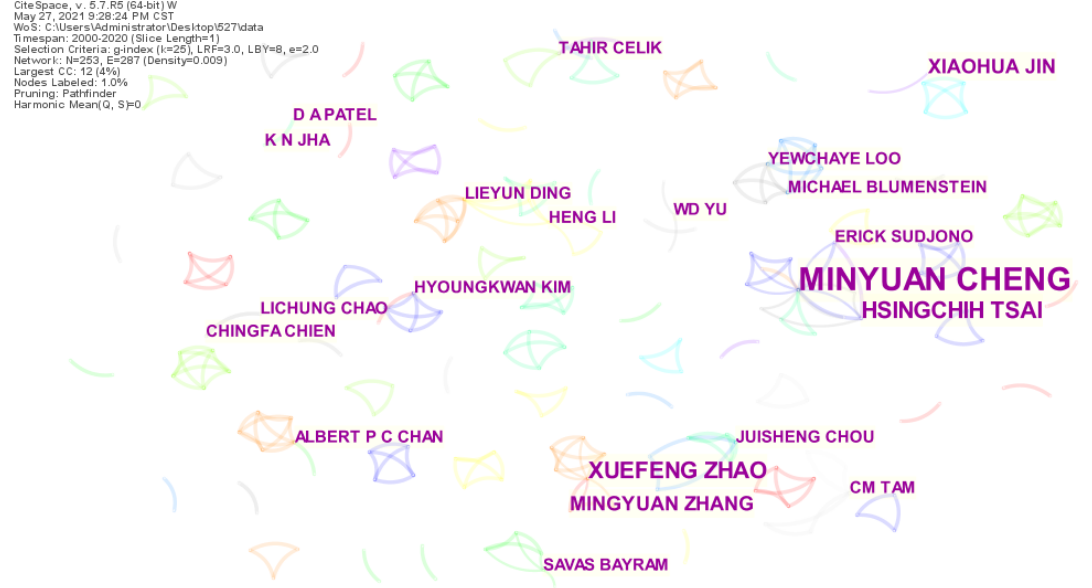
Figure 2. Network of co-authorship in research on ANN in CM [15,28–137].